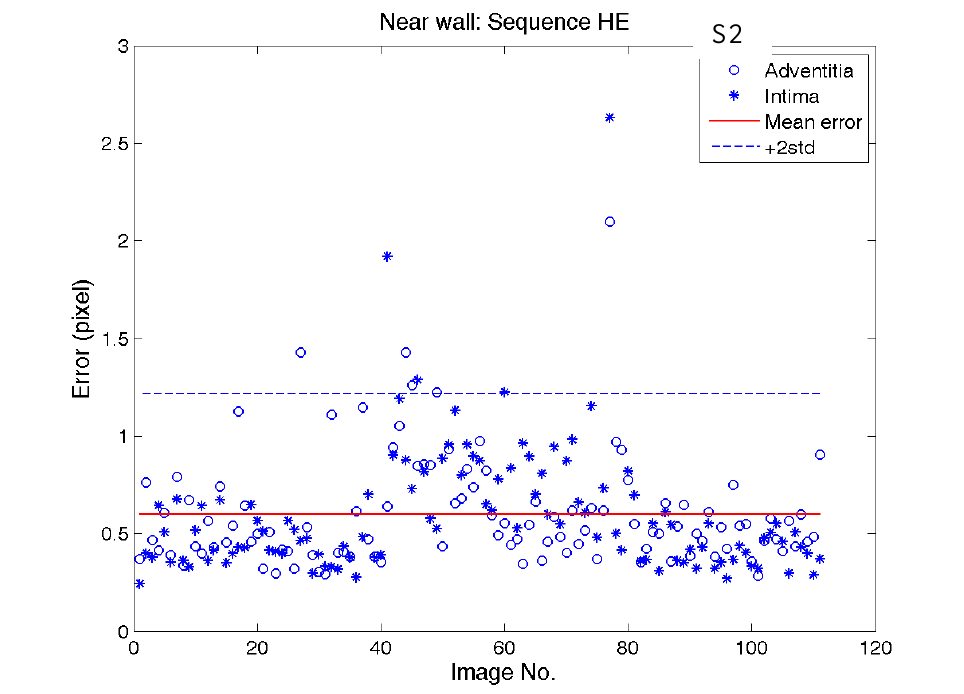
Figure 12. ―*‖ and ―o‖ denote the near wall error distribution of intima and adventitia along image number, respectively. The total averaged error of the near wall is 0.6-pixel in sequence